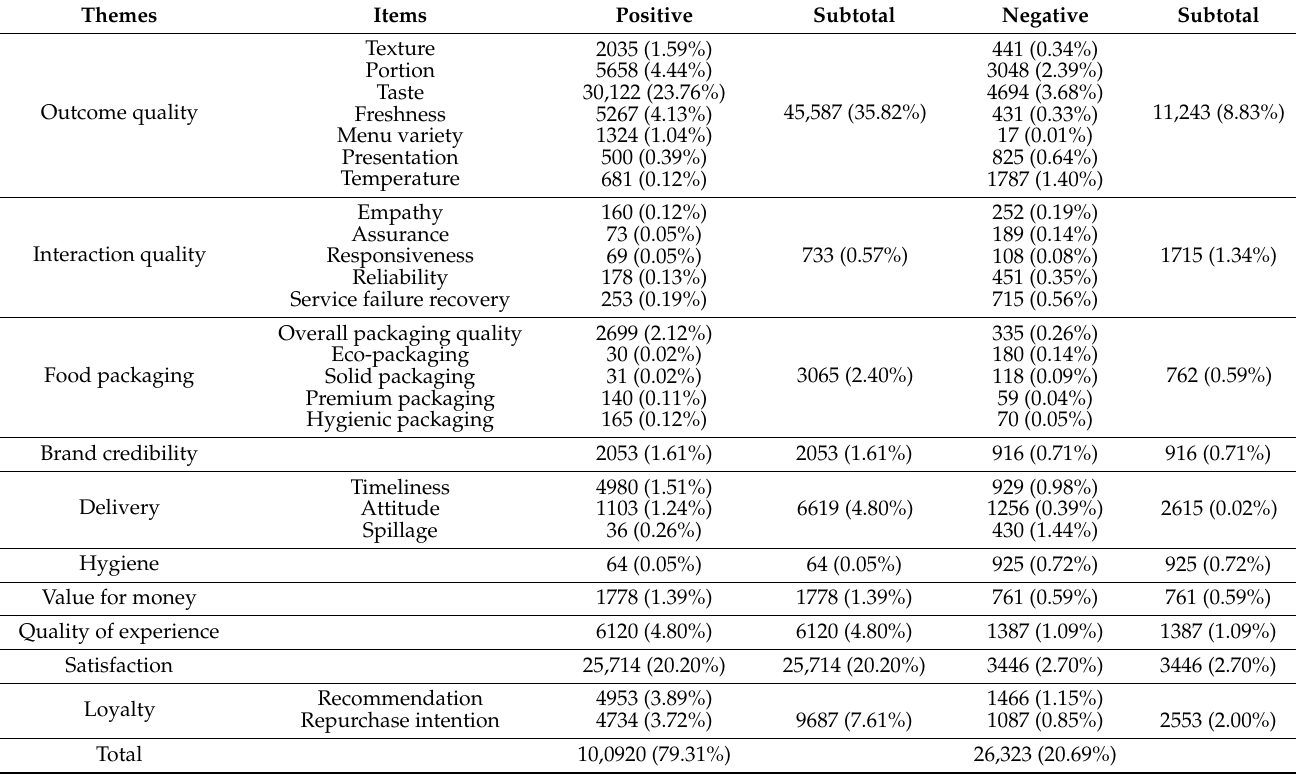
Table 2. Items and frequency of customers’ O2O platform